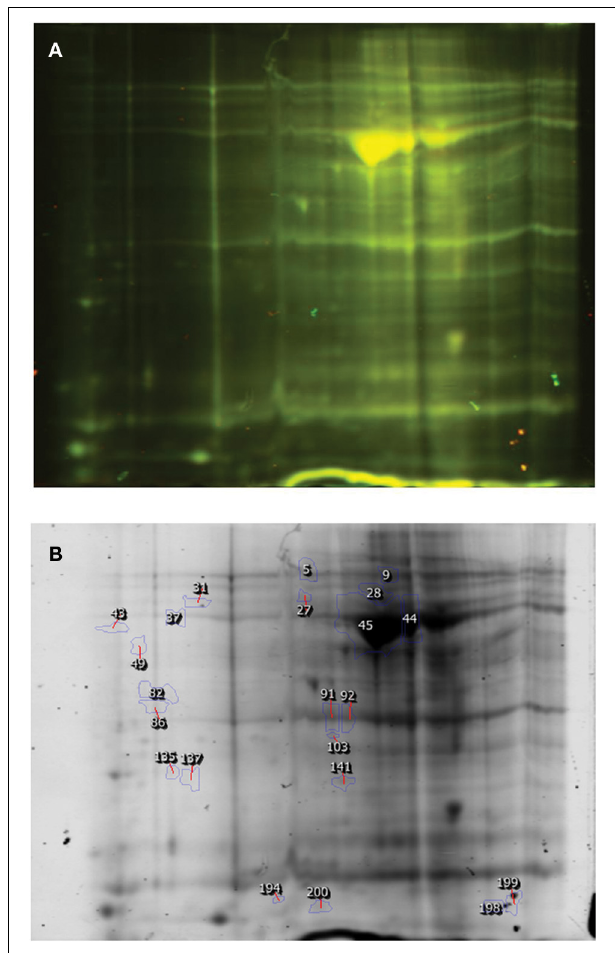
FIGURE 2 | DIGE image of Spermatogenic cell proteins (Karan Fries × Tbarparkar). (A) DIGE image, (B) Differentially expressed spots.